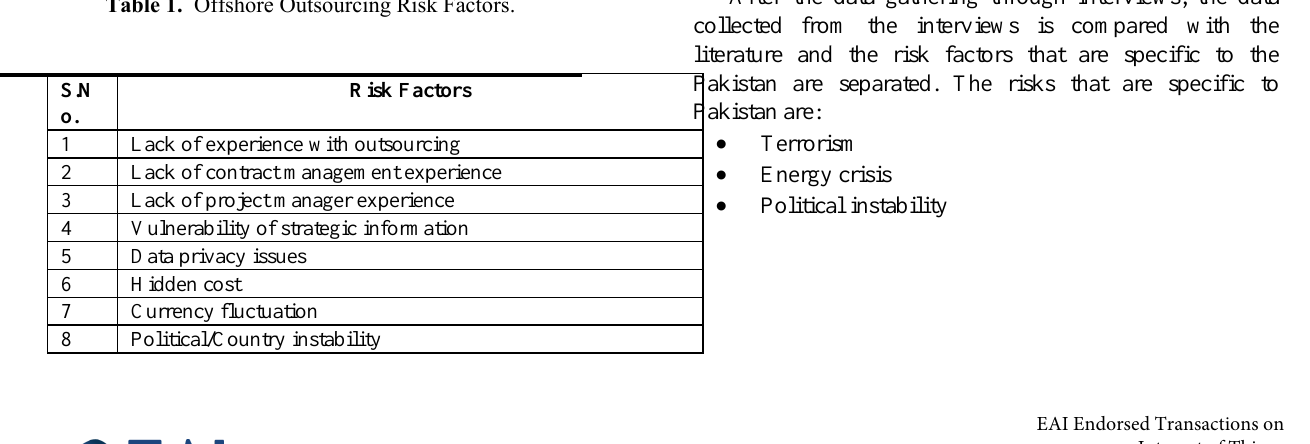
Table 1. Offshore Outsourcing Risk